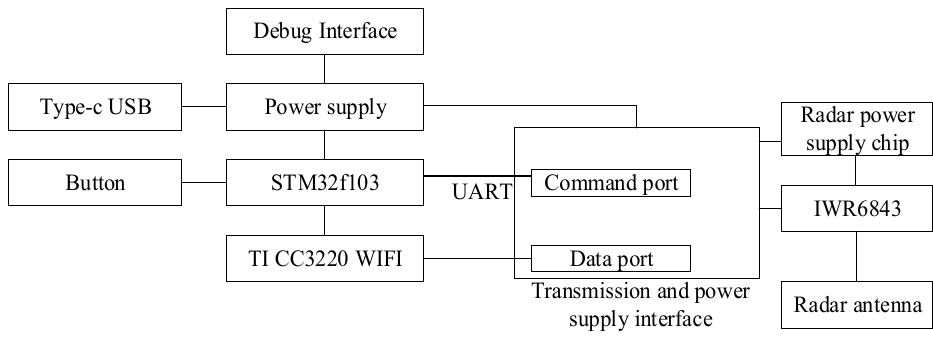
Figure 3. Hardware overall structure diagram.